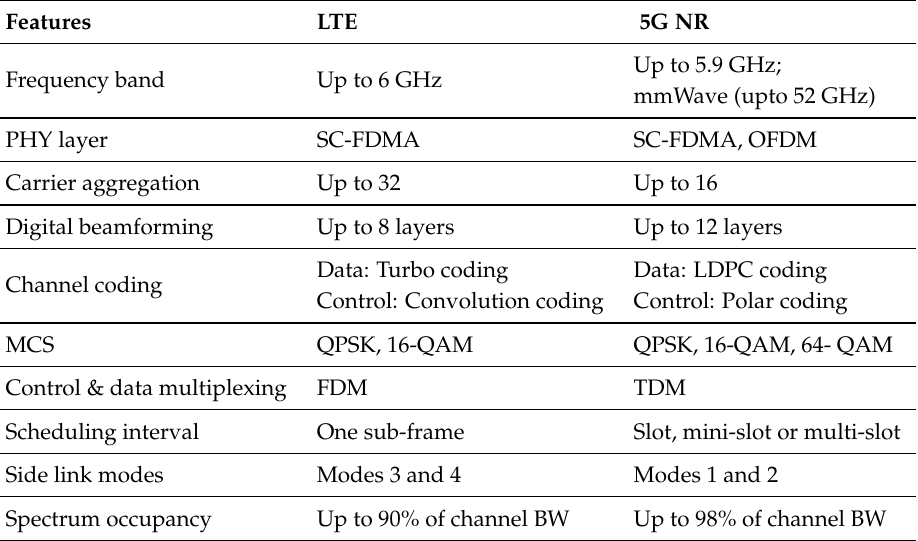
Table 4. Summary of advancement in 5G NR over 4G